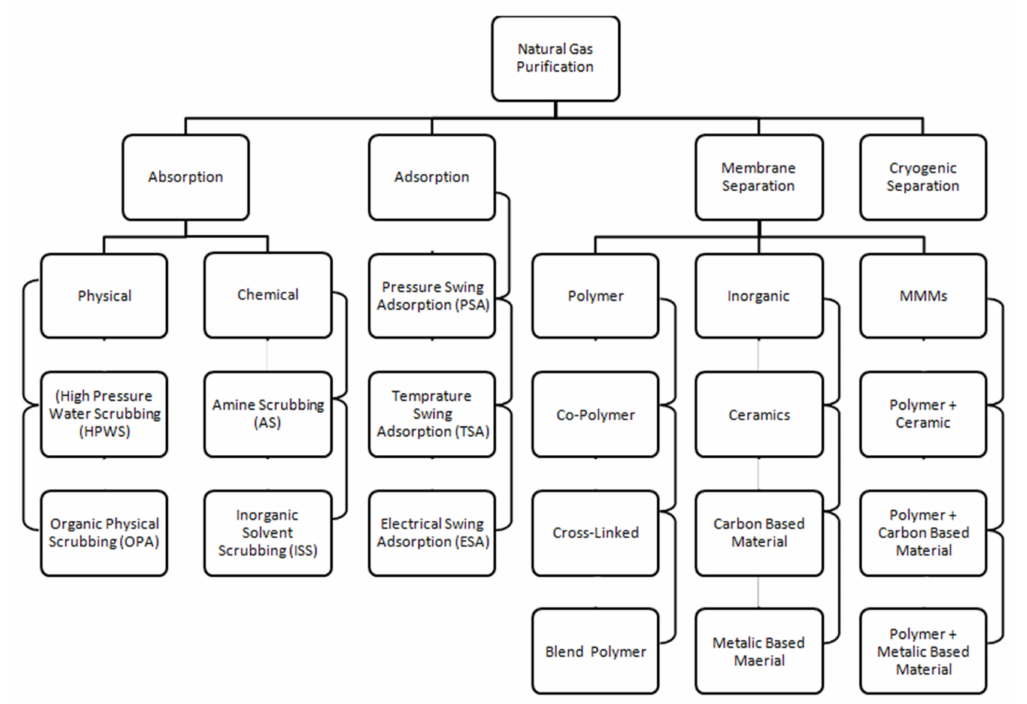
Figure 1. Natural gas purification technologies [23]. Reprinted/adapted with permission from Ref. [23]. Copyright 2022,